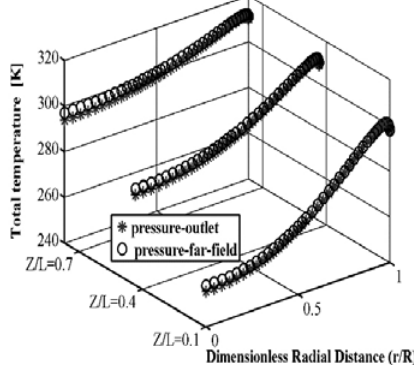
Fig. 12. Comparison of the total temperatures at different longitudinal sections regarding two different boundary conditions